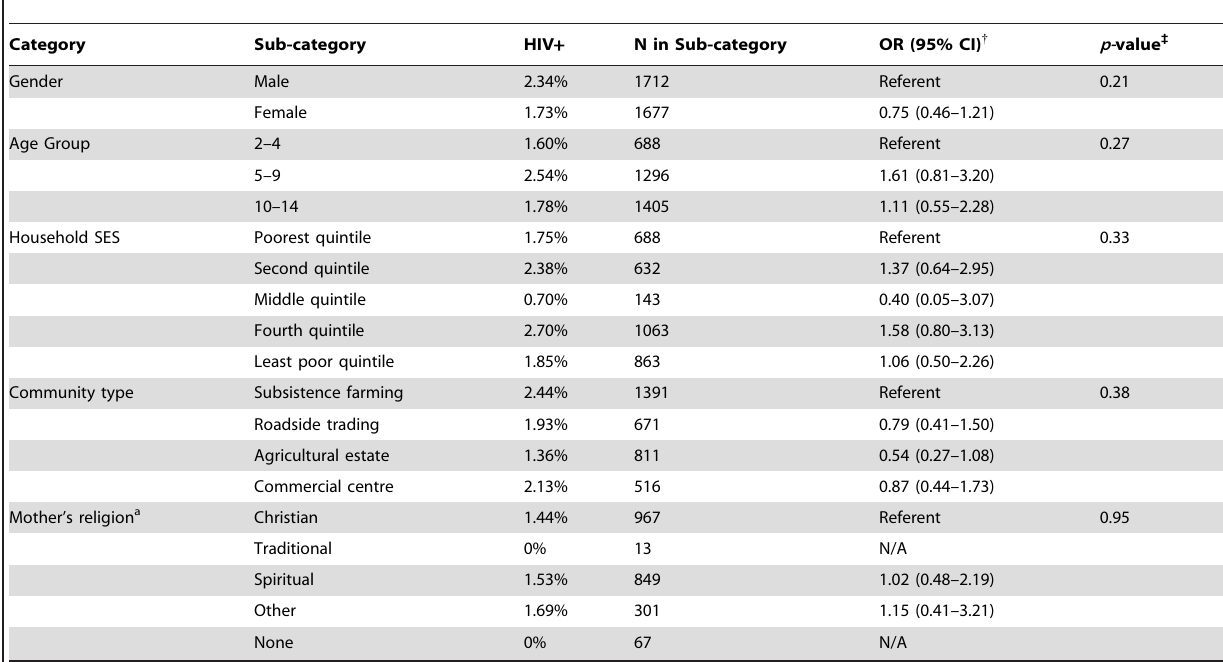
Table 1. Association between demographic characteristics and HIV infection in